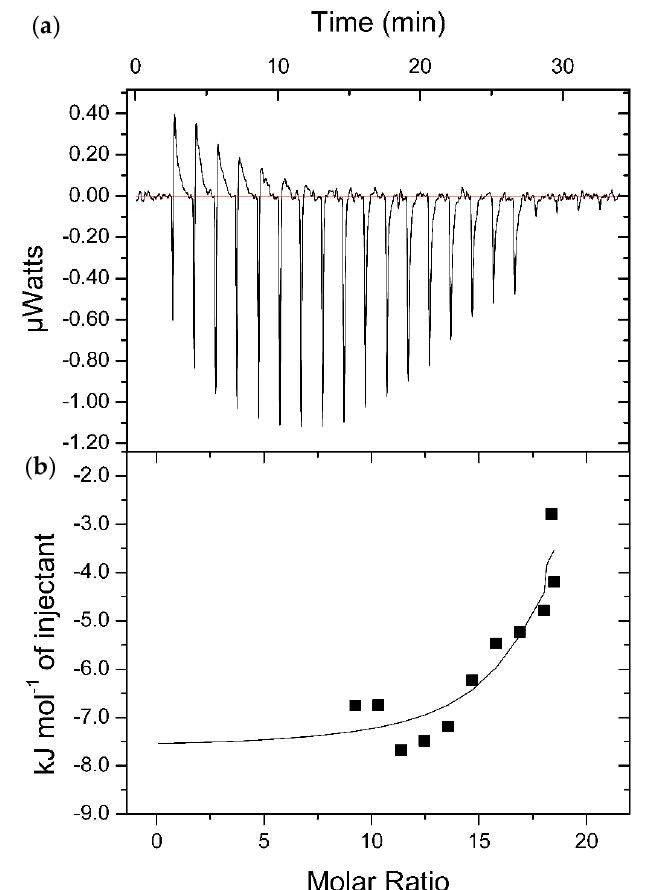
Figure 3. ( a ) ITC titration curves and ( b ) the corresponding fitting curve for MMIPs and P5 peptide in water. In this experiment, a suspension of MMIPs (33 μg/mL, 6.6 μM, assuming 0.198 mmol/g binding sites) was titrated with a solution of P5 peptide (1.0 mg/mL: total concentration; 0.66 mM).